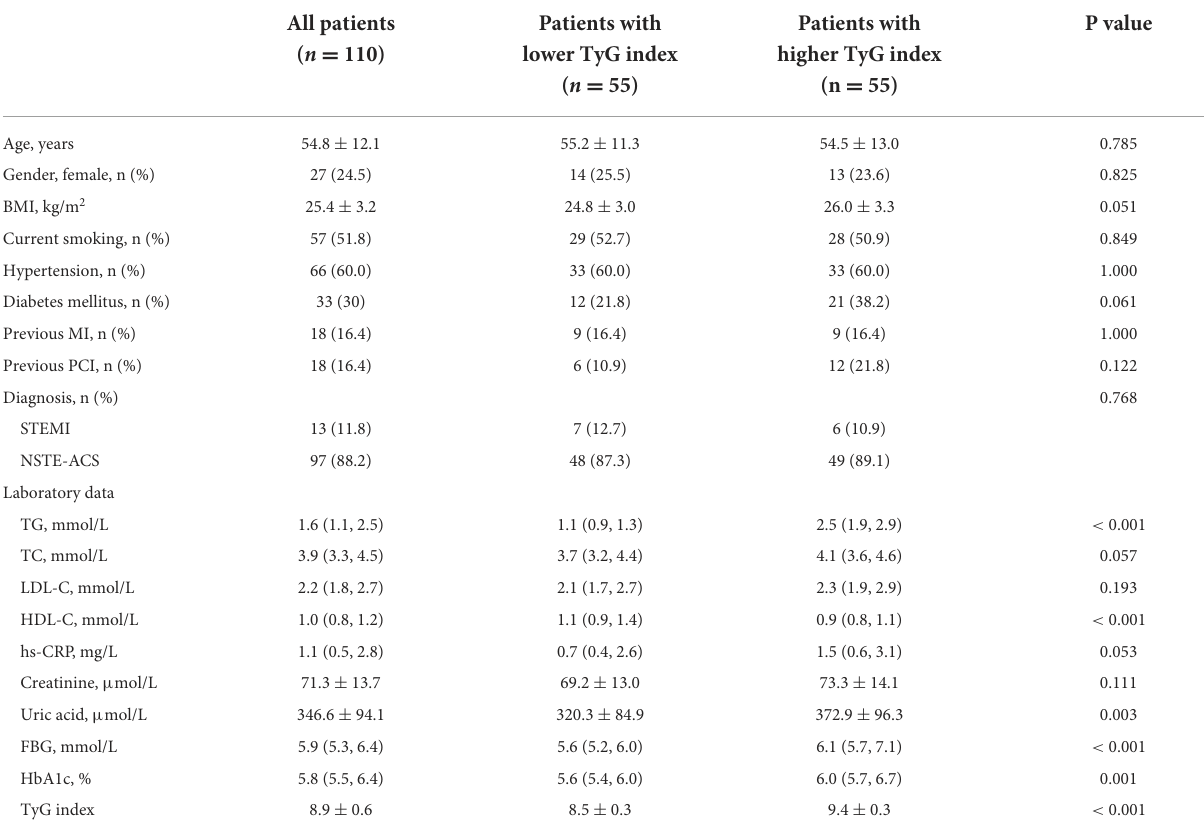
TABLE 1 Baseline characteristics of the study